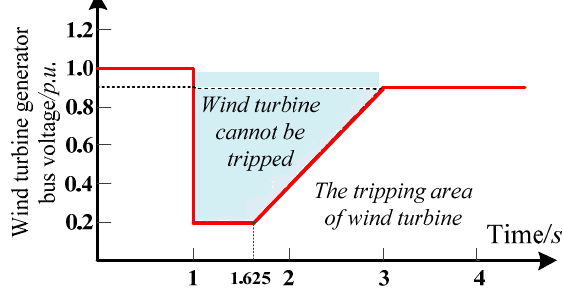
Figure 2. The low voltage ride-through of wind generator in China.